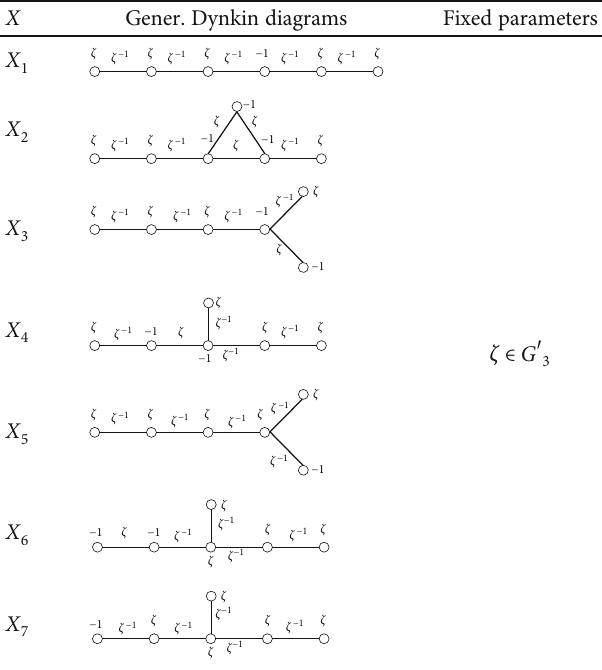
Algorithm 28: GoodNeighborhoods ( rs ). Table 1: Finite dimensional Nichols algebra of diagonal type over k ( p ≠ 3